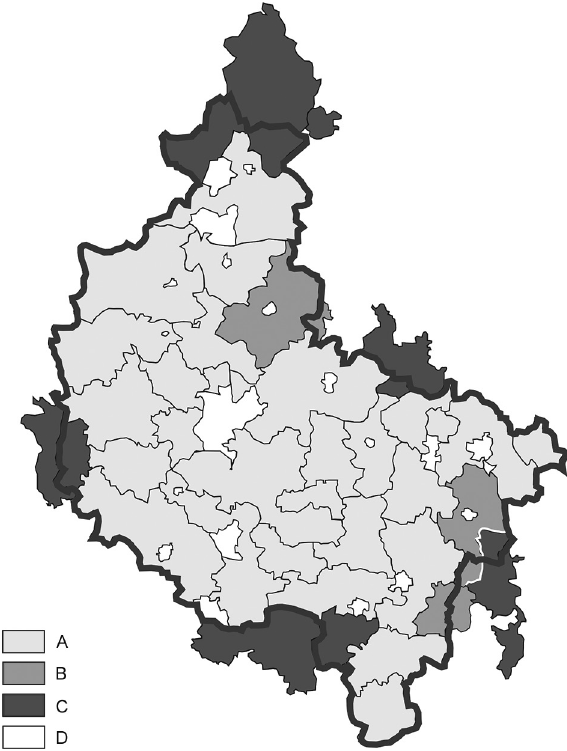
Fig. 3. Distribution of LAGs in Wielkopolskie